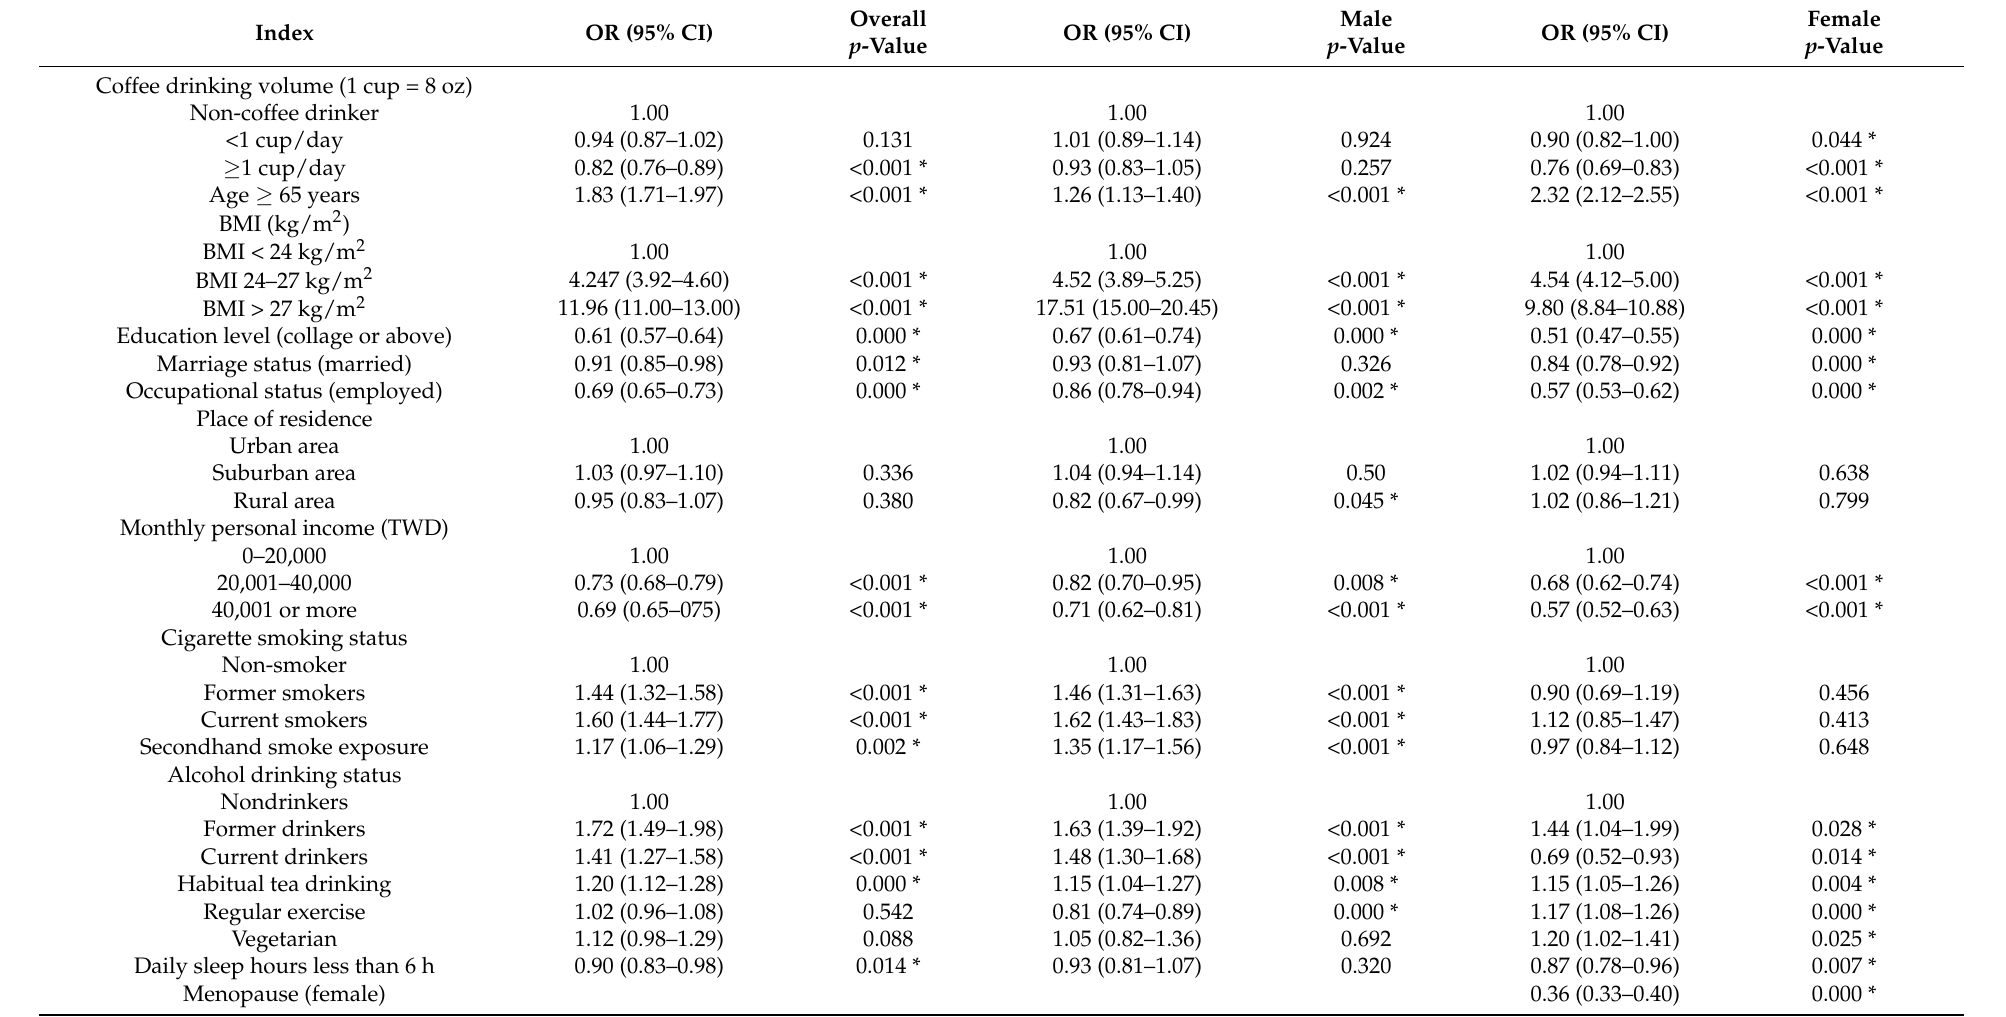
Table 2. The unadjusted odds ratios of daily coffee drinking volume and general characteristics in metabolic syndrome in Taiwanese participants aged 30–79